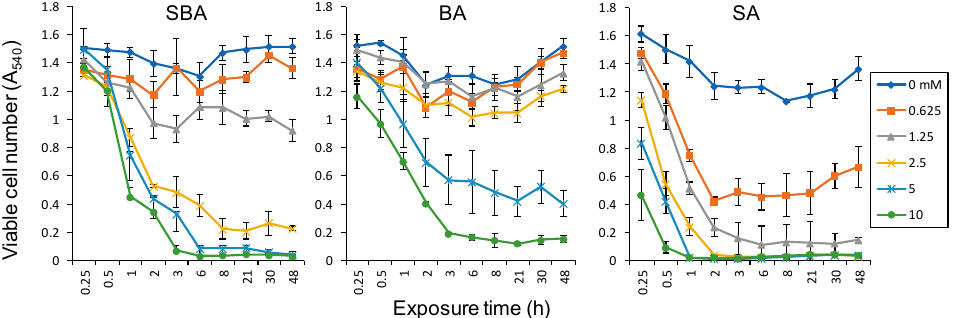
Figure 3. Minimum exposure time required for cytotoxicity induction by SBA, BA, and SA. HSC-2 cells were incubated for the indicated times without (control) or with 0, 0.625, 1.25, 2.5, 5, or 10 mM for each compound, and replaced with fresh drug-free medium. Cells were incubated for a total of 48 h and viable cell number was determined by MTT methods. Each value represents the mean ± S.D. of triplicate